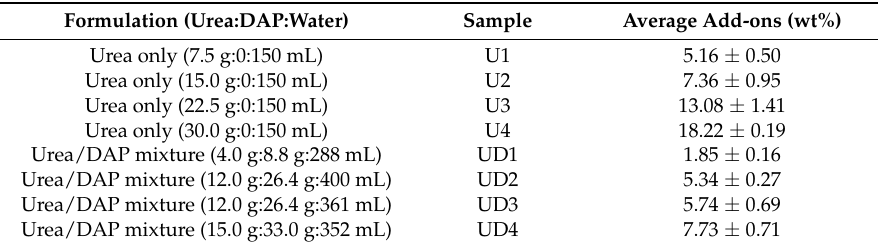
Table 1. Fabric treatment